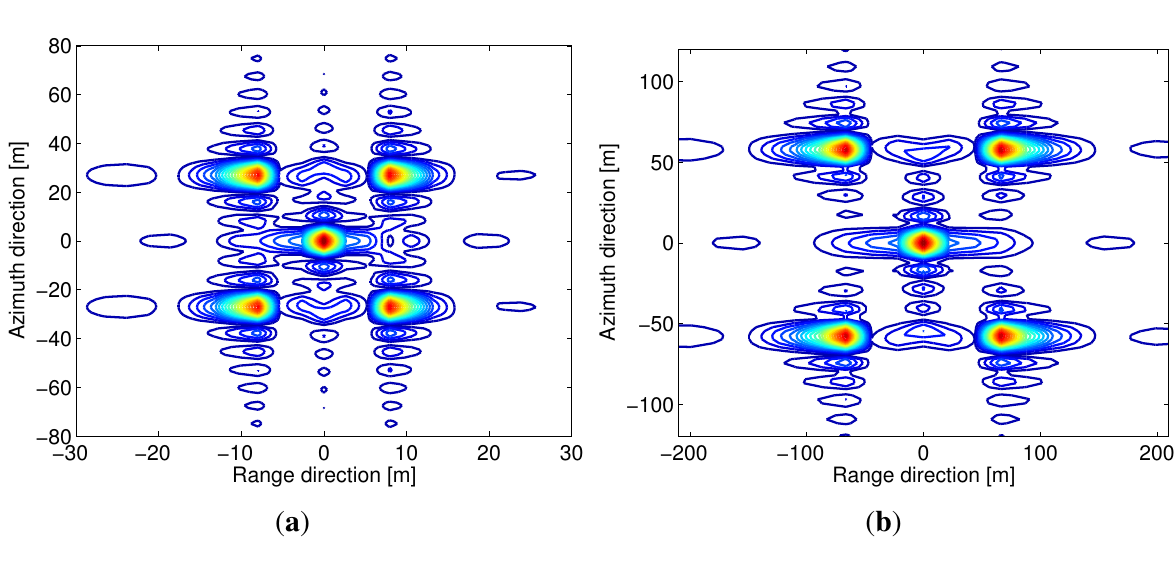
Figure 8. Processing results with the equivalent velocity and NCS combined algorithm. ( a ) Configuration A; ( b ) Configuration B; ( c ) Configuration